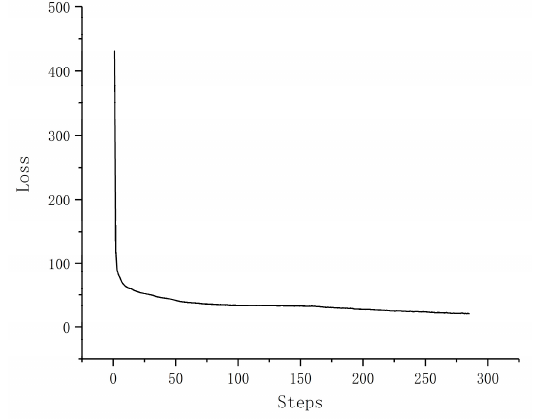
Figure 3. The training error curve of the electricity consumption model.